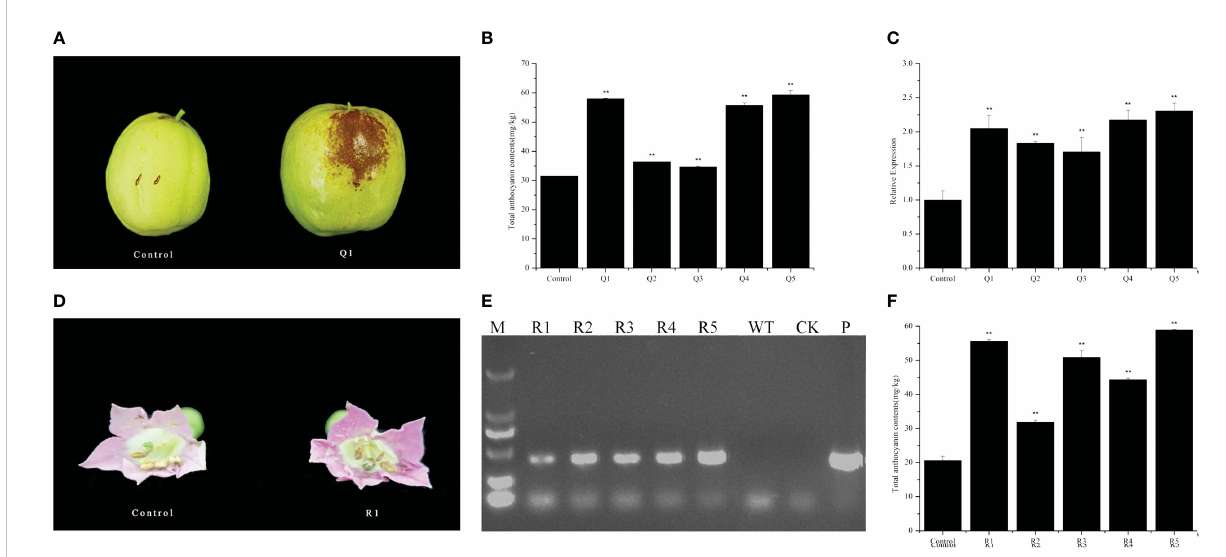
FIGURE 5 Functional analysis of ZjFAS2 . (A) Fruit phenotypes of the FMG-null (Control) and ZjFAS2-transient expression fruit (Q1). (B) Comparison of total anthocyanin content between FMG-null (Control) and ZjFAS2-transient expression fruits (Q1-Q5). (C) Expression of ZjFAS2 in the FMG-null (Control) and ZjFAS2-transient expression fruits (Q1-Q5) by qRT-PCR. (D) Flower phenotypes of the SR1-null (Control) and ZjFAS2-transgenic lines (R1). ZjFAS2 pART-CAM (E) The examination of ZjFAS2-overexpressed lines (R1-R5), SR1 as negative control (WT), H 2 O as blank control (CK), and 35S:: vector (P) by PCR. (F) Expression of ZjFAS2 in the SR1-null (Control) and ZjFAS2-transgenic lines (R1-R5) by qRT-PCR. ** indicates signi fi cantly different at P < 0.01. Error bars indicate standard deviations (SDs) from three biological replications.